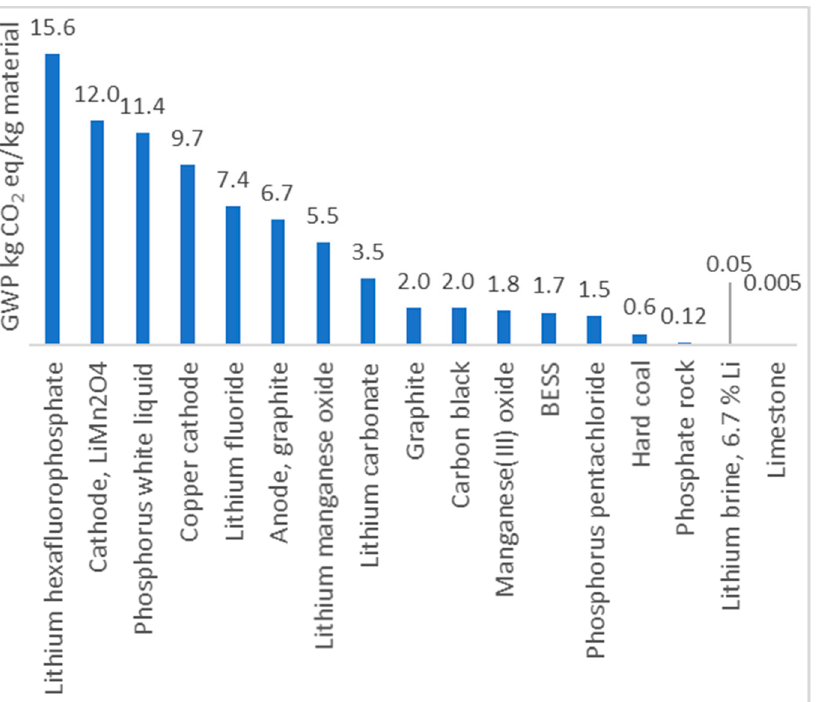
Figure 8. GWP of material productions in the entire system to show the contributing materials.